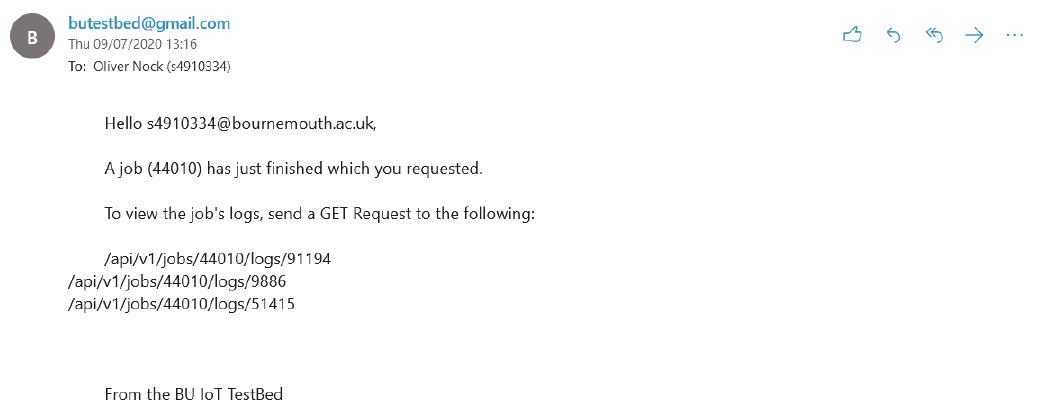
Figure 11. Example of communication with the user via email informing of log